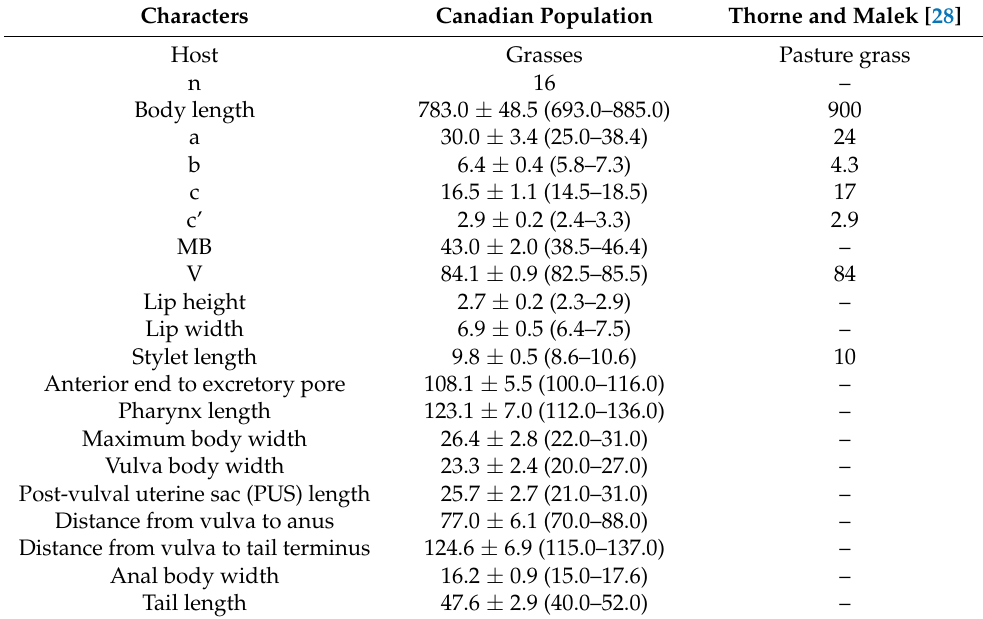
Table 2. Morphometrics of female Nothotylenchus similis from Canada and from the original de- scription. All measurements are in µ m and in the form: the mean ± standard deviation and/or the range.